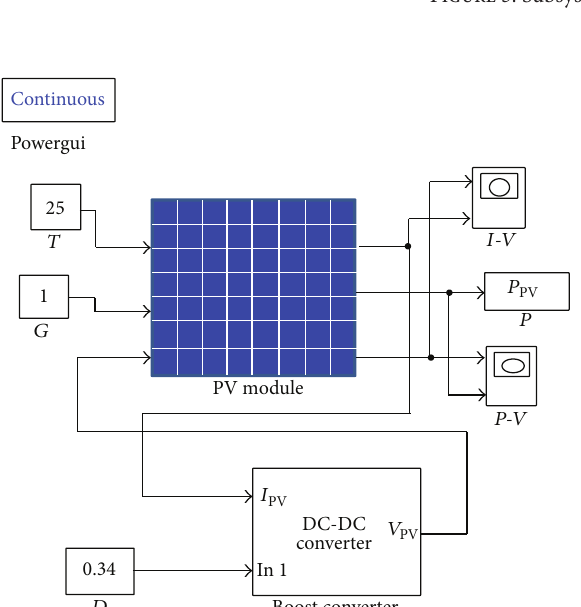
Figure 5: Subsystem of boost converter.